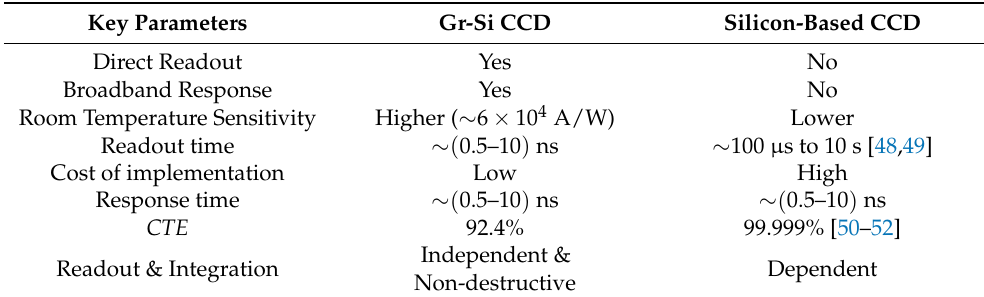
Table 1. The comparison between conventional silicon-based CCDs with novel Gr-Si CCD pixels is presented for different parameters, i.e., readout techniques, response time, cost of fabrication, and charge transfer